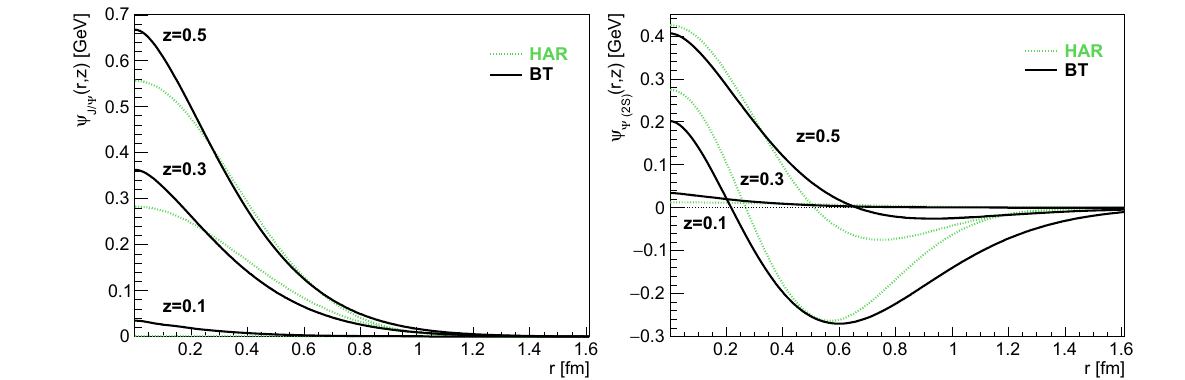
Fig. 3 The LC wave function (cid:5) V ( r , z ) for J /ψ( 1 S ) (left panel) and ψ (cid:2) ( 2 S ) (right panel) mesons for different quark momentum fractions z . The distribution function (cid:5) V ( r , z ) is generated by two models for